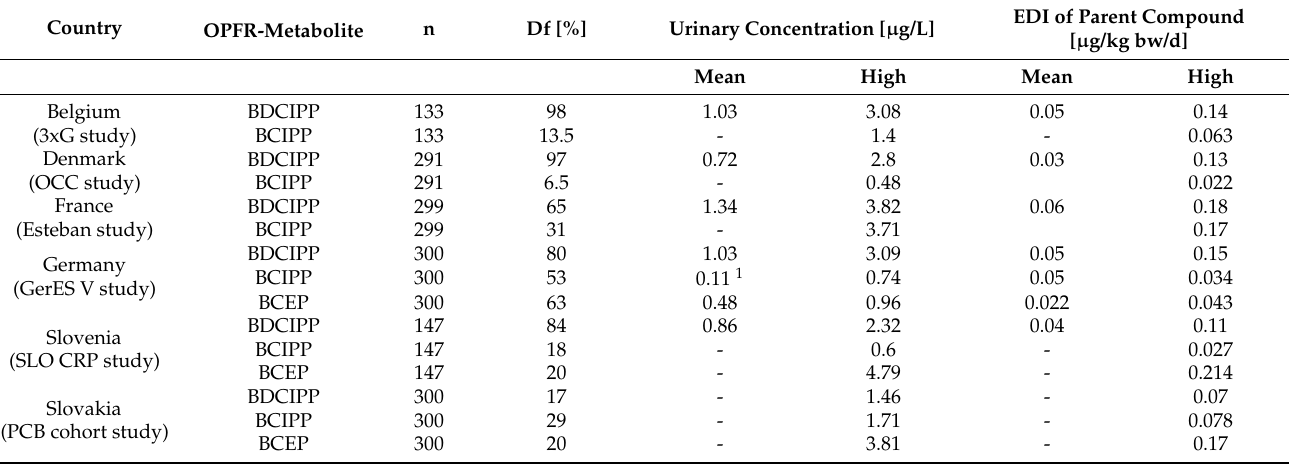
Table 3. Urinary BDCIPP, BCIPP and BCEP concentration levels and the estimated daily intakes (EDI) of their parent compounds TDCIPP, TCIPP and